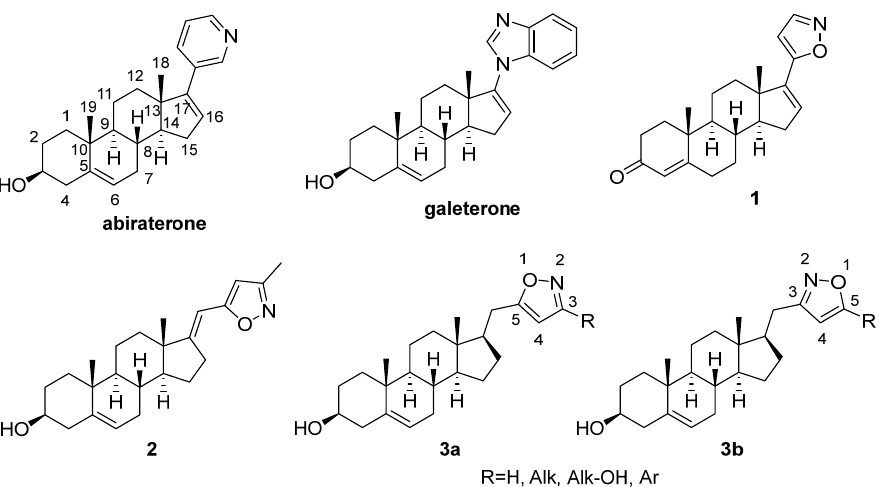
Figure 1 . Structures of some heterocyclic steroids with anti-prostate cancer effects and target com- pounds 3a and 3b .